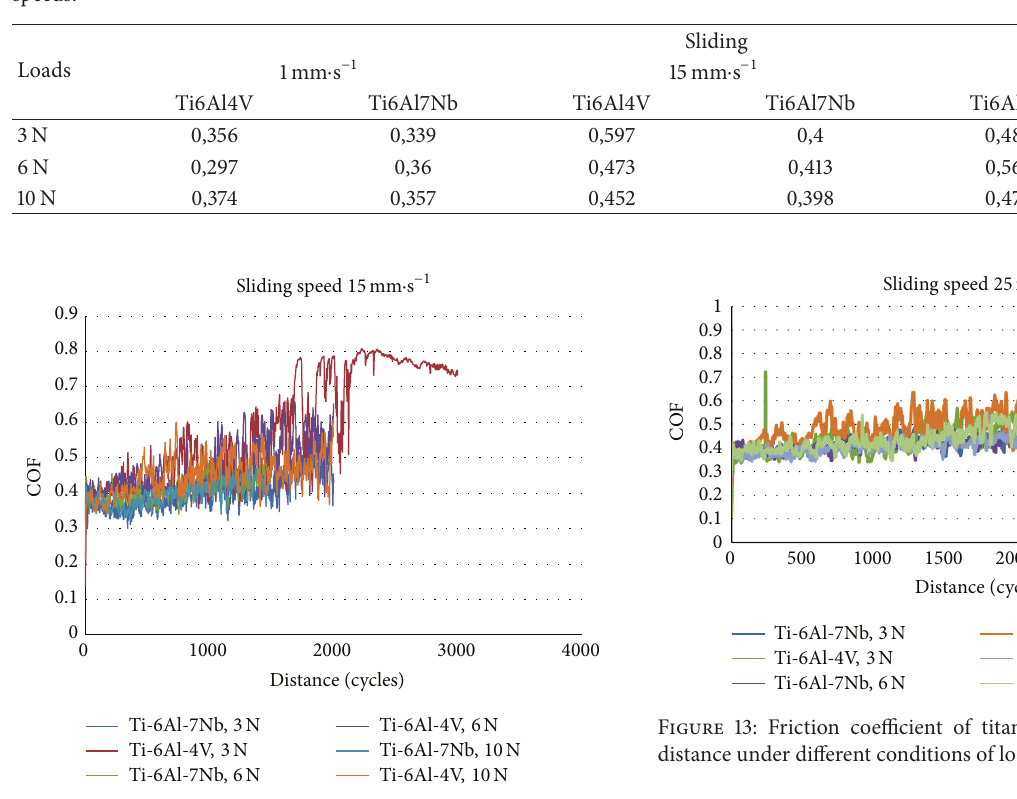
Figure 12: Friction coefficient of titanium alloys versus sliding distance at 15 mm ⋅ s −1 .